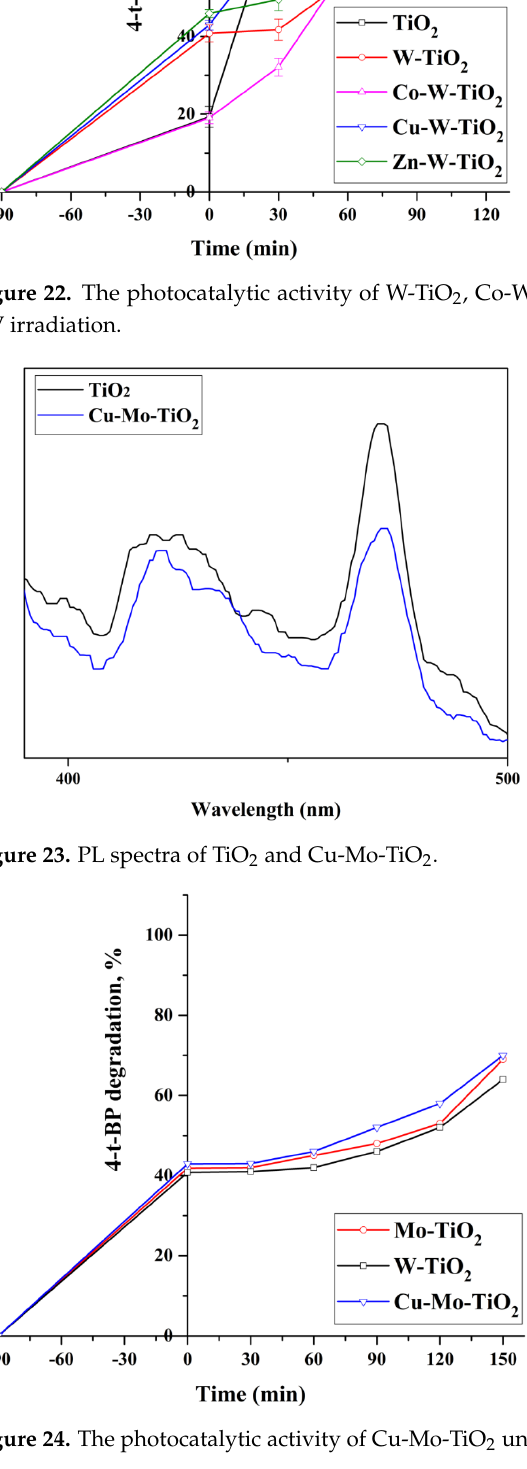
Figure 24. The photocatalytic activity of Cu ‐ Mo ‐ TiO 2 under solar light irradiation. In Table 2, the results of this work are compared with previously reported ones. Table 2. Photocatalytic degradation of 4 ‐ t ‐ BP by different materials.